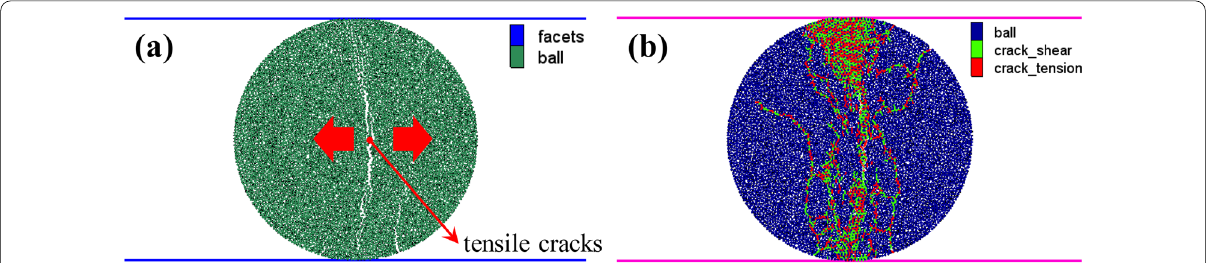
Fig. 19 Failure mode and crack state when the water–cement rate was 0.42: a failure mode; b crack state.